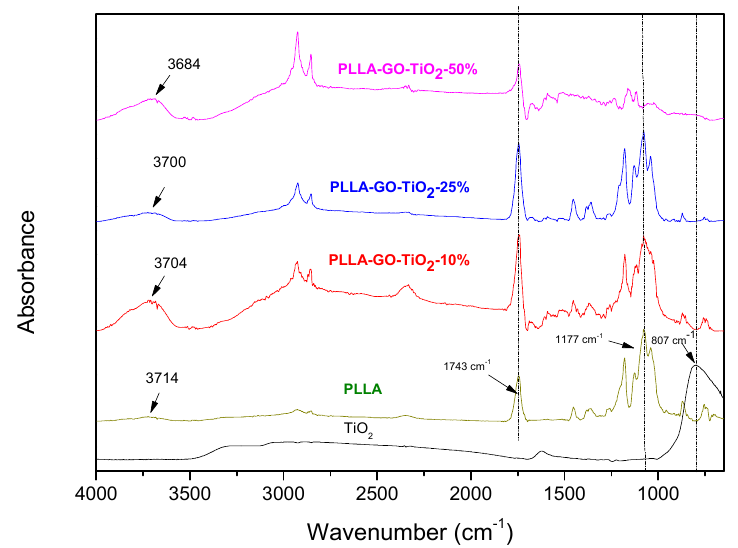
Figure 3. FTIR spectra of prepared films containing different GO-TiO 2 contents in comparison with neat PLLA and TiO 2 nanoparticles.